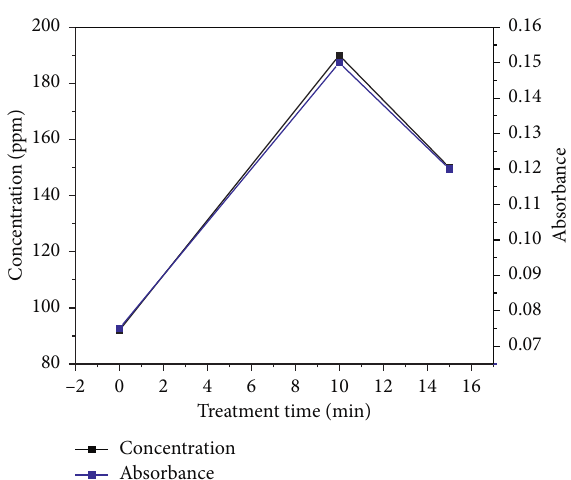
Figure 14: Absorbance and concentration of chromium ions with treatment time (5kV, 19.56kHz, and 5L/min).